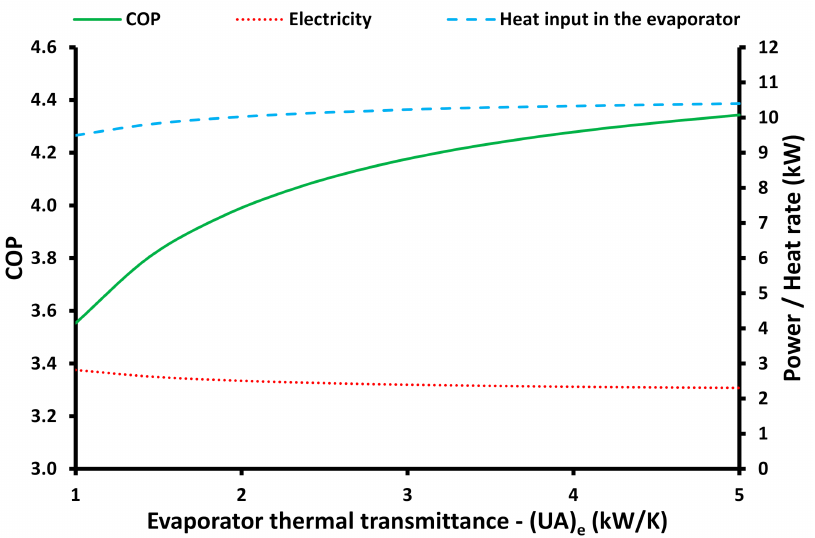
Figure 12. The impact of the evaporator thermal transmittance in the evaporator on the COP, electricity consumption and heat input in the